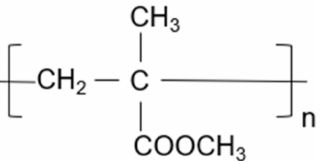
Figure 1. Chemical compound of polymethyl methacrylate (chamber surface).